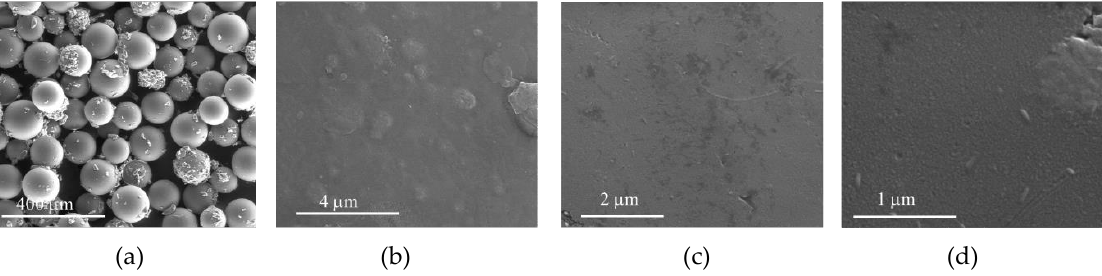
Figure 16. SEM micrographs of CAT-4-MR-H 2 O 2 after two cycles in oxidation reactions using H 2 O 2 as the oxidant. ( a ) 250×, ( b ) 25,000×, ( c ) 40,000×, ( d ) 100,000×.